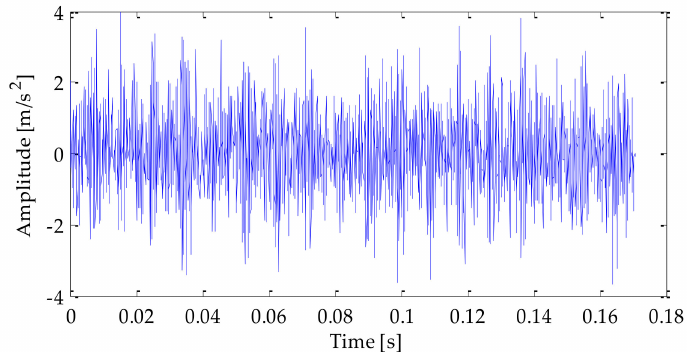
Figure 35. Time domain analysis of the mixed